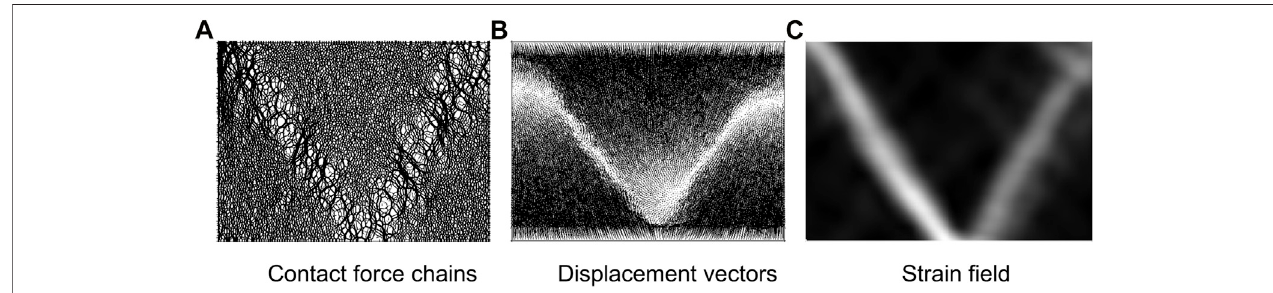
FIGURE 14 | Shear bands during dissolution. Pressure solution creates the positive feedback mechanism that leads to shear band formation (modi fi ed from Cha and Santamarina, 2019b).